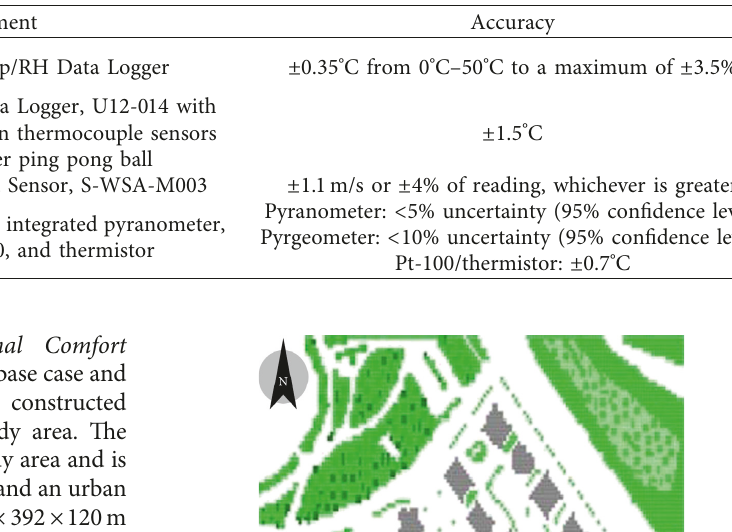
Table 1: Equipment used for field measurement.